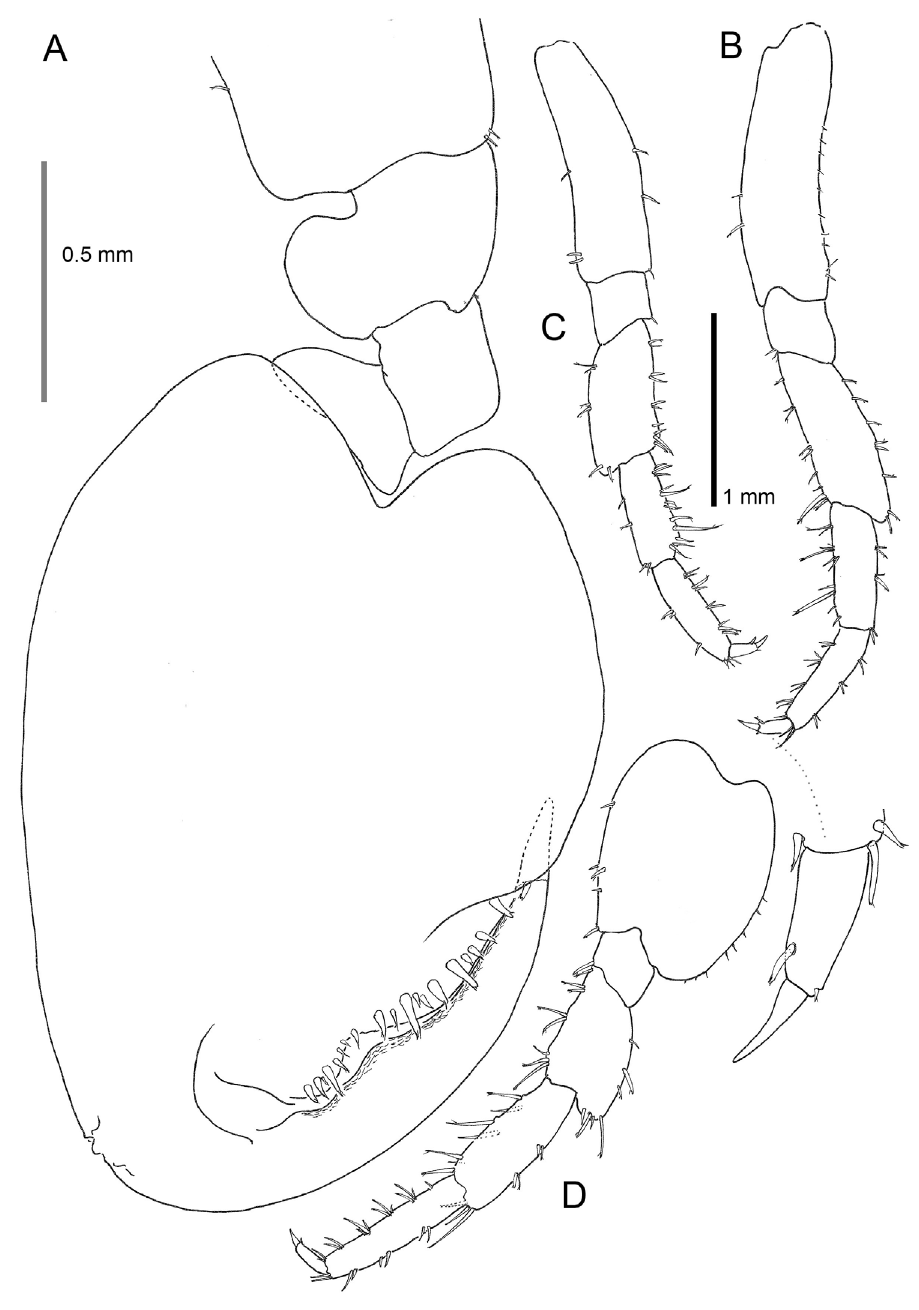
Figure 5. Cryptorchestia ruffoi sp. n., paratype male 10.4 mm (RMNH) A gnathopod 2 B pereopod 4 C pereopod 3 D pereopod